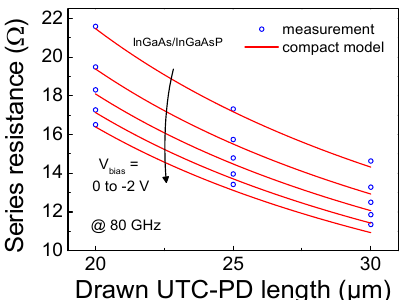
( b ) Figure 11. UTC-PD junction capacitance as functions of the active device area and the applied reverse bias: ( a ) InGaAs/In- GaAsP UTC-PD ( b ) GaInAsSb/InP UTC-PD. 3.2.2. Intrinsic Series Resistance Extraction The overall series resistance can be extracted from the real part of the intrinsic 𝑍 (cid:2869)(cid:2869) -